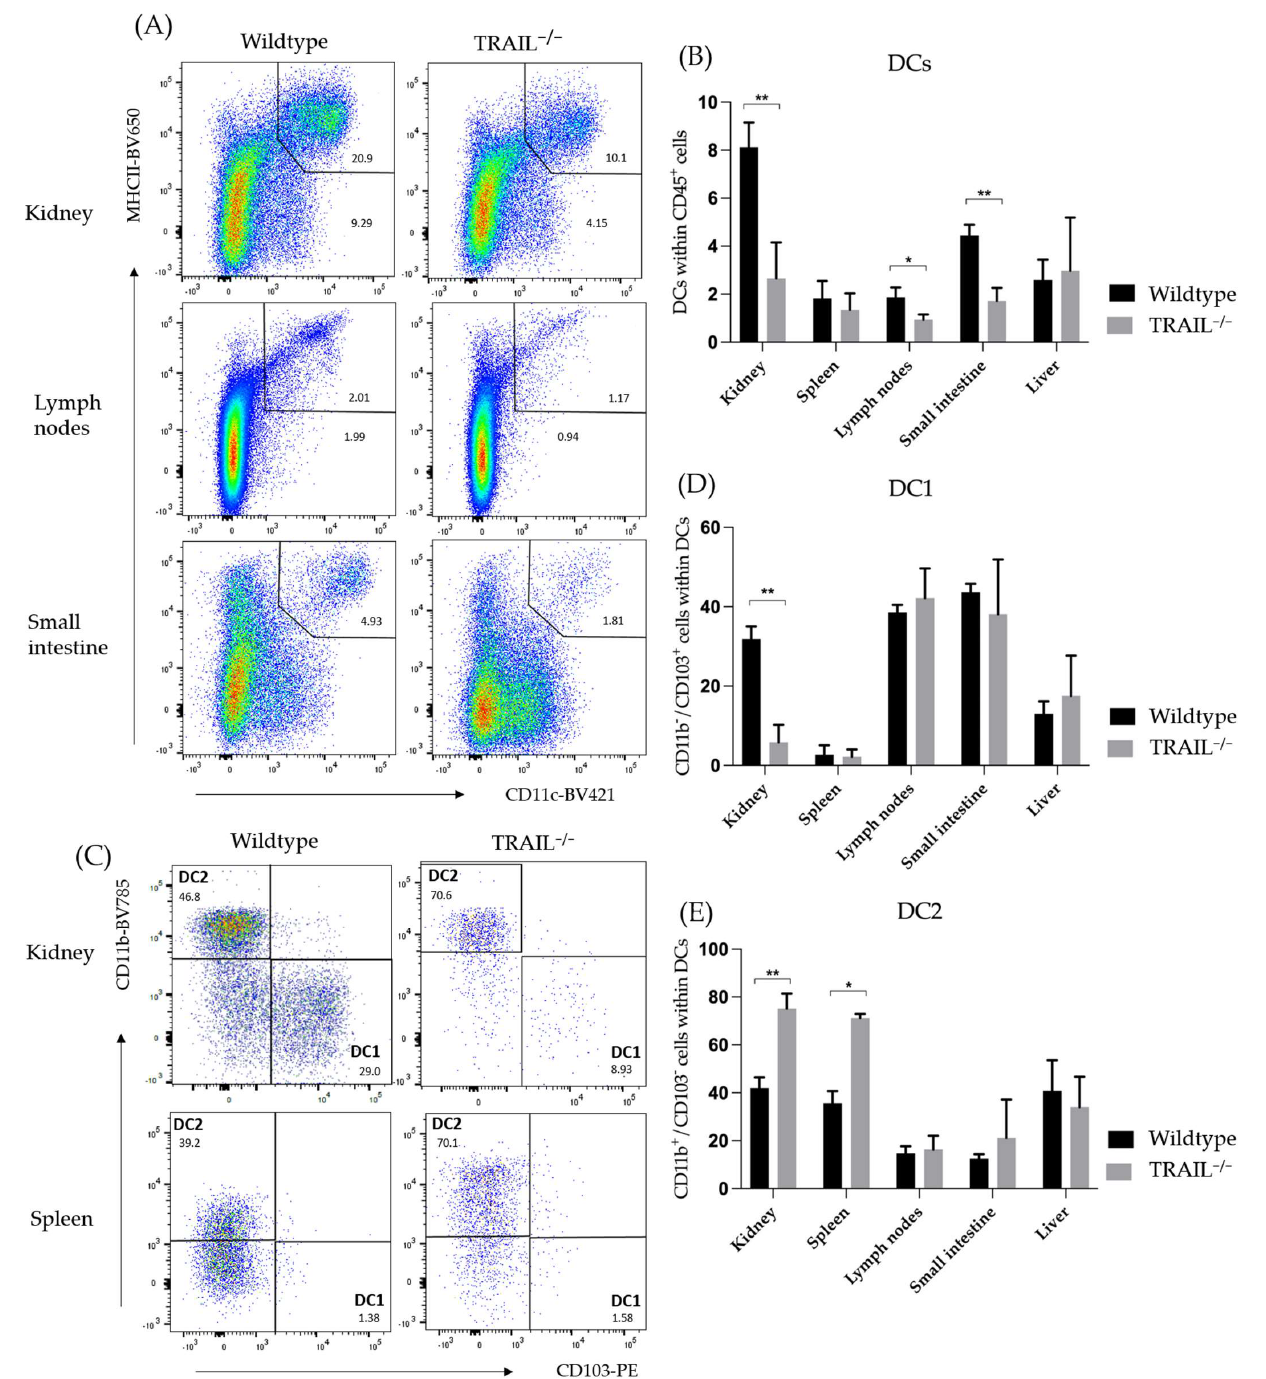
Figure 1. Distribution of DCs in the kidney, spleen, lymph nodes, liver, and small intestines of TRAIL −/− mice versus wildtype C57BL/6 mice. ( A ) Exemplary dot plots illustrate higher frequencies of CD11c + MHCII + dendritic cells in the kidney, lymph nodes, and small intestine of a TRAIL −/− mice. ( C ) Exemplary dot plots illustrate distribution of CD103 + MHCII + DC1 and CD11b + MHCII + DC2 sub- types in kidney and spleen of TRAIL −/− mice versus wildtype C57BL/6 mice. ( B ) Histogram compares means ± SEM of all CD11c + MHCII + DCs in the different organs ( n = 6). ( D , E ) Exemplary dot plot illustrate the distribution of CD103 + MHCII + DC1 and CD11b + MHCII + DC2 subtypes in kidney, spleen, lymph nodes, small intestine, and liver (( B , D , E ) t -test, n = 6 per group, * p < 0.05, ** p < 0.01).